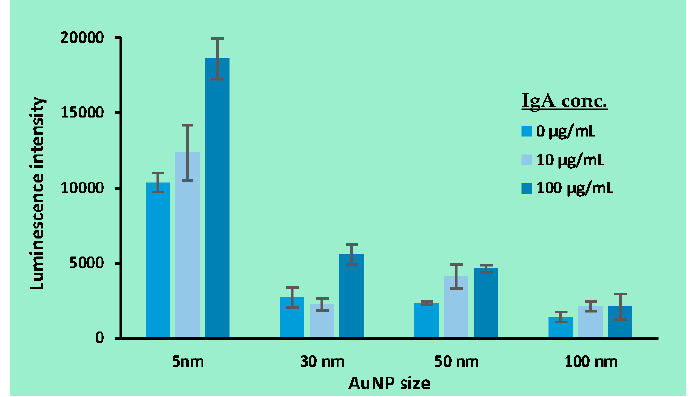
Figure 5. Luminescence from AuNPs (5 nm, 30 nm, 50 nm, 100 nm) after immunoassay for